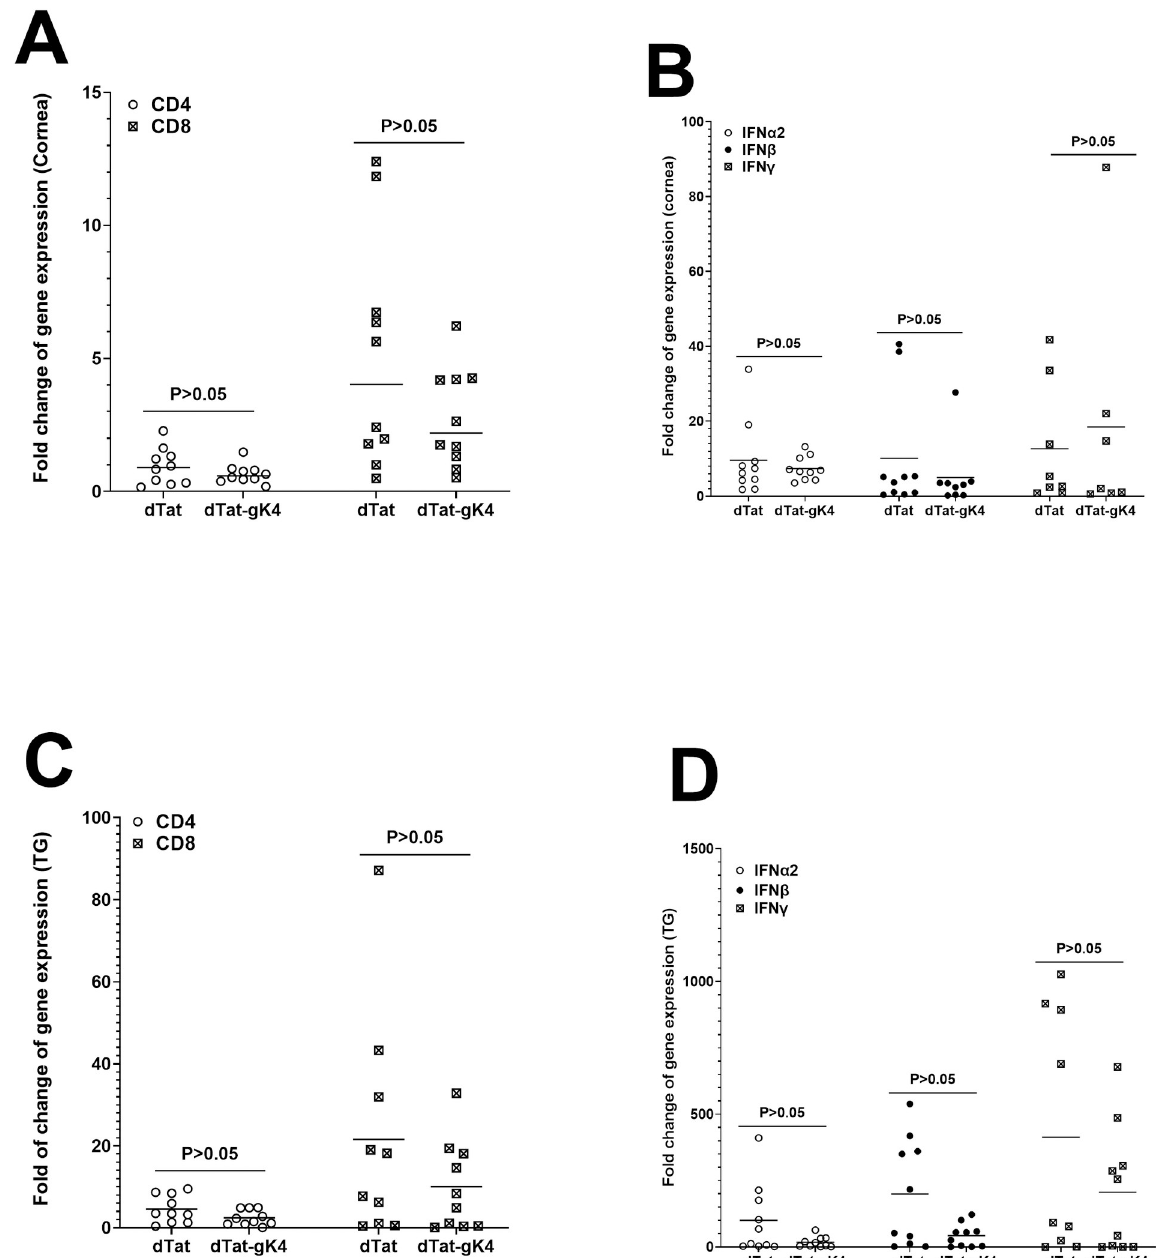
Fig 8. Effect of dTat-gK4 treatment on expression of CD4, CD8, IFN α 2, IFN β , and IFN γ transcripts in cornea and TG of ocularly infected mice. BALB/c mice were infected as described in Fig 7. Levels of CD4, CD8, IFN α 2, IFN β , and IFN γ transcripts in cornea and TG were determined on day 4 PI by qRT-PCR. The ratio of expression of each mRNA in the cornea and TG was normalized to its expression in the cornea and TG of uninfected control mice. GAPDH expression was used to normalize relative expression of each transcript in the cornea and TG of infected mice. Each bar represents the mean ± SEM from five mouse corneas or TG. Panels: (A) gK expression in cornea; (B) gB expression in cornea; (C) ICP0 expression in cornea; (D) UL20 expression in cornea; (E) gK expression in TG; (F) gB expression in TG; and (G) ICP0 expression in